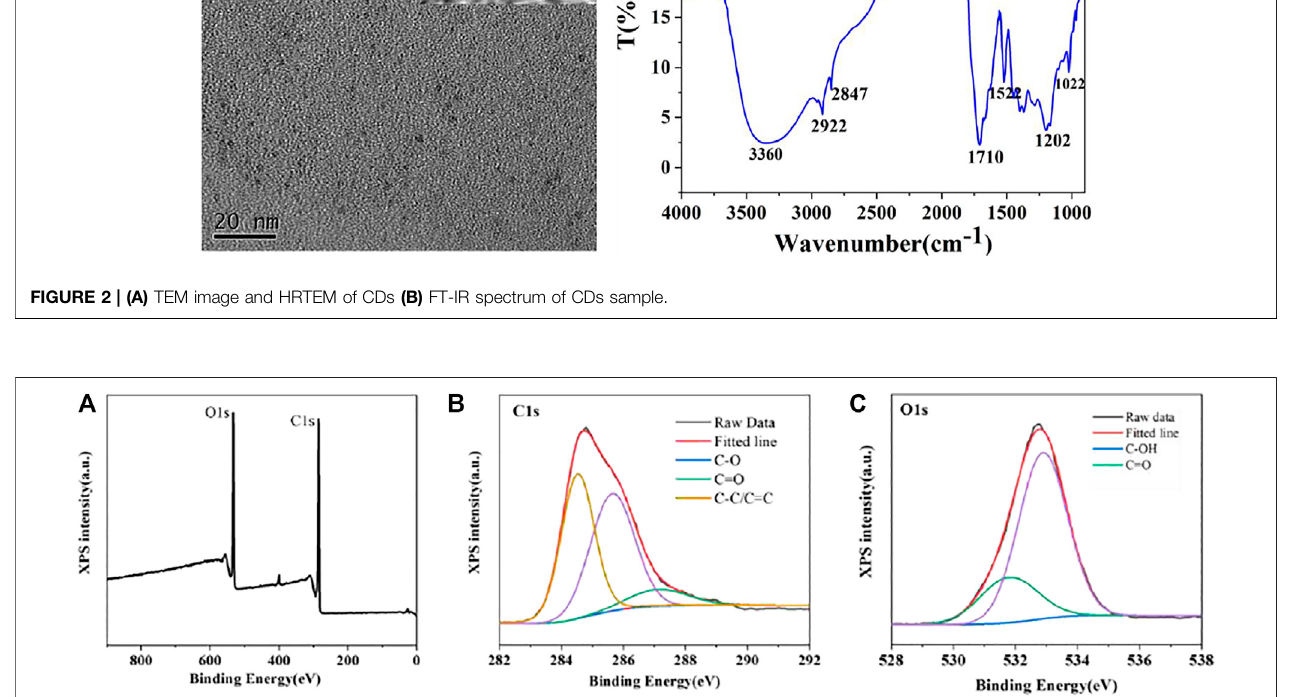
FIGURE 3 | XPS spectra of CDs (A) Full-scan spectrum and high-resolution spectrum of C 1s (B) and O 1s (C) .